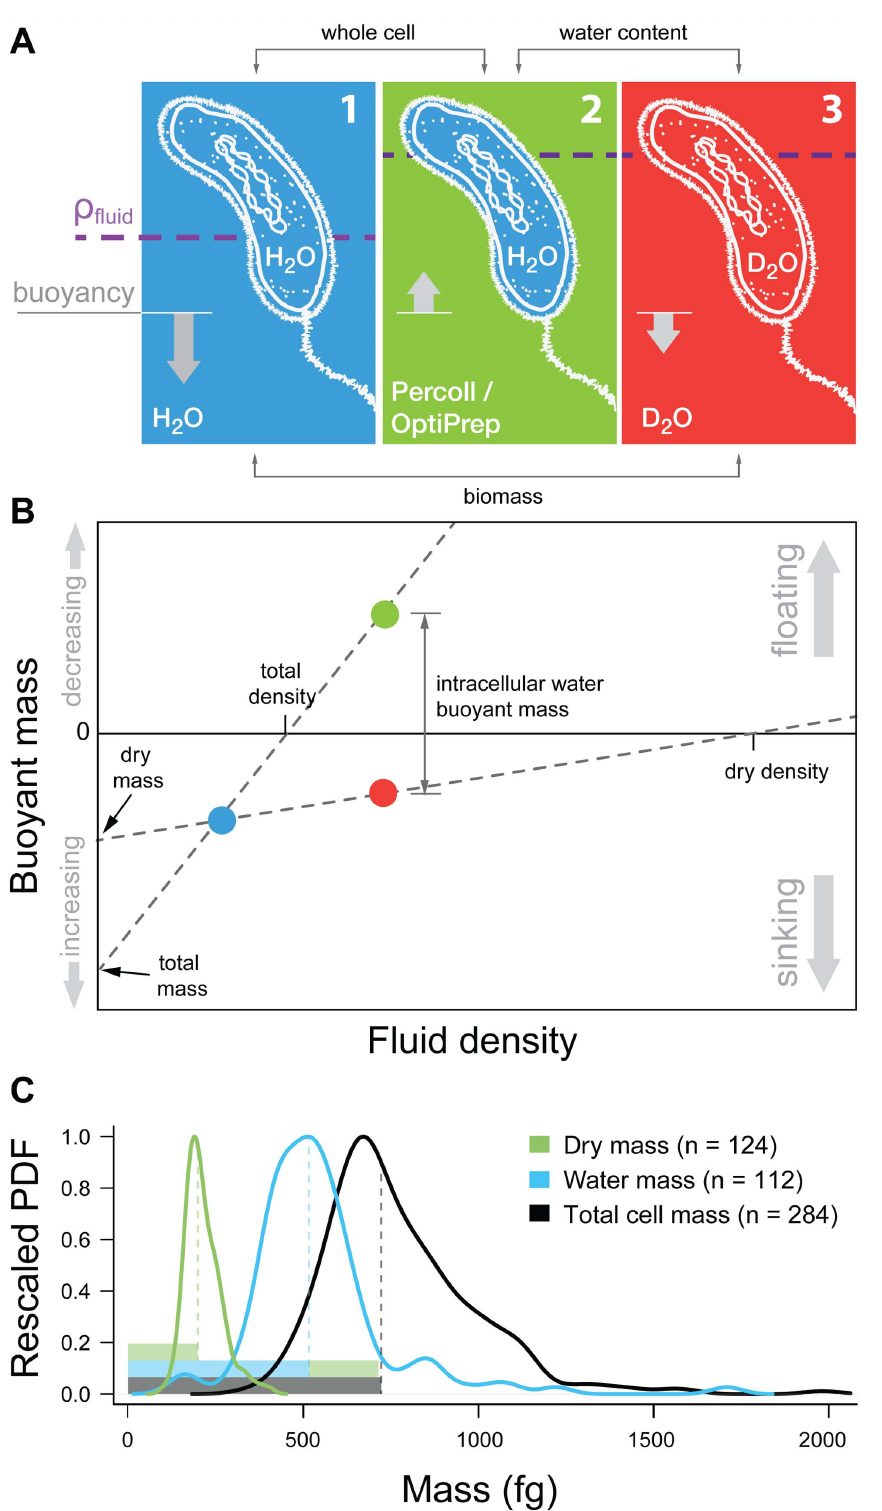
Figure 1. Buoyancy of a cell in fluids of different densities and membrane permeabilities. a) In an H 2 O or D 2 O based fluid (1 or 3), the cell sinks as a result of the dry content’s density being higher than the surrounding fluid. In a dense impermeable fluid (2), the buoyancy of the cell’s water content dominates and the cell floats. b) The pairing of the different buoyant mass measurements allows the determination of different biophysical parameters of the cell as shown in the plot (not to scale). c) Kernel density estimates of probability densities for dry mass, water mass and total mass of a sample of fixed stationary-phase E. coli . Functions were rescaled so that their maxima were one. Solid bars represent sample medians.